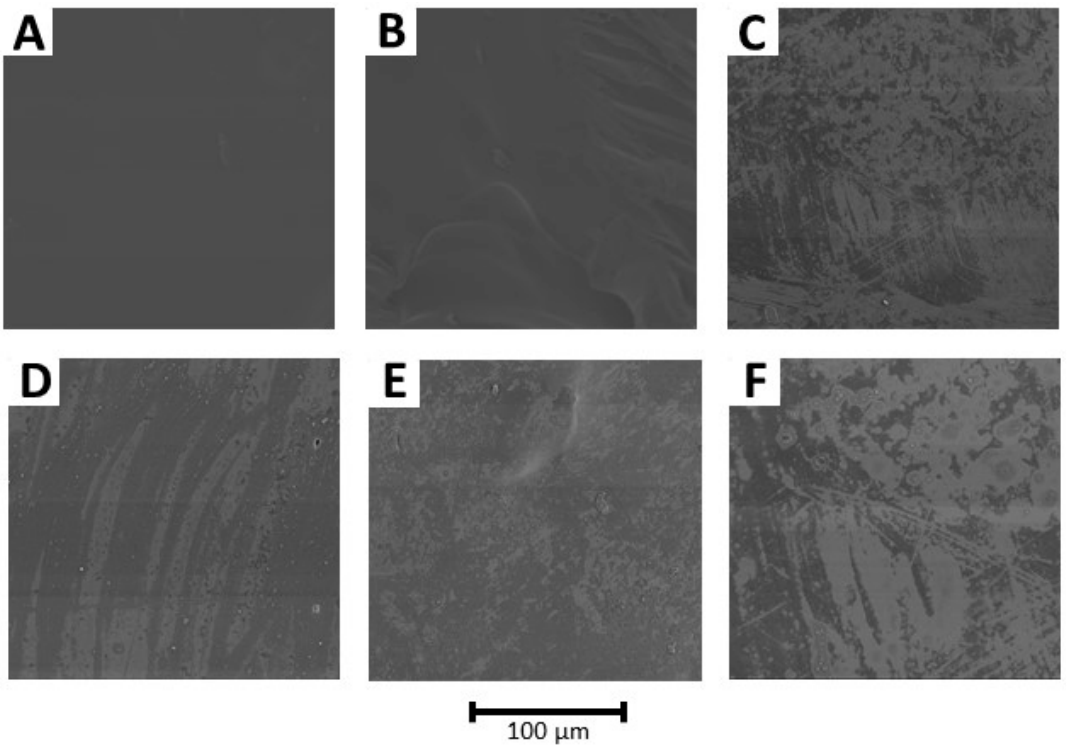
Figure 5. SEM images of the blends. PLA ( A ); P95C5 ( B ); P85C15 ( C ); PLAGE ( D ); P95C5GE ( E ); P85C15GE ( F ). Magnification of 200×.